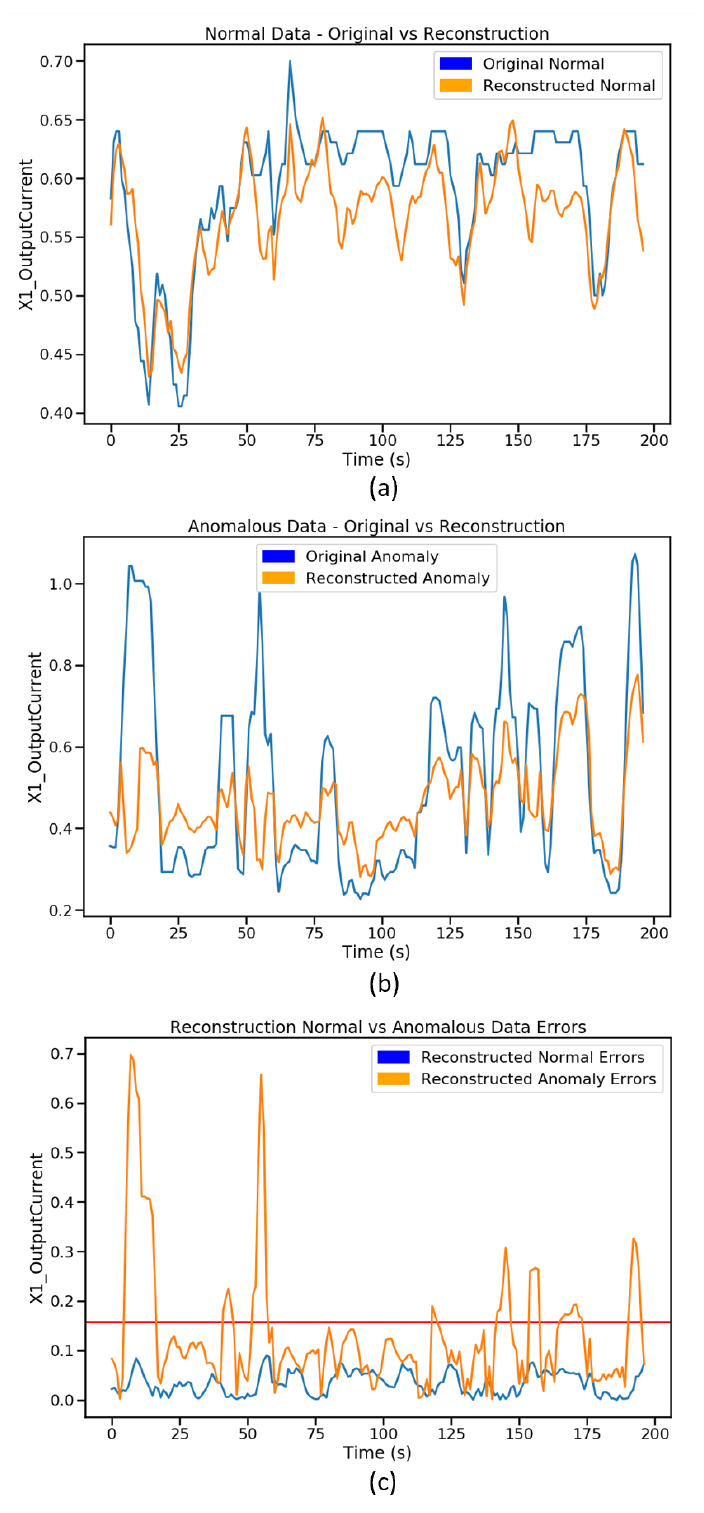
Figure 7. X1-OutputCurrent time series measurement